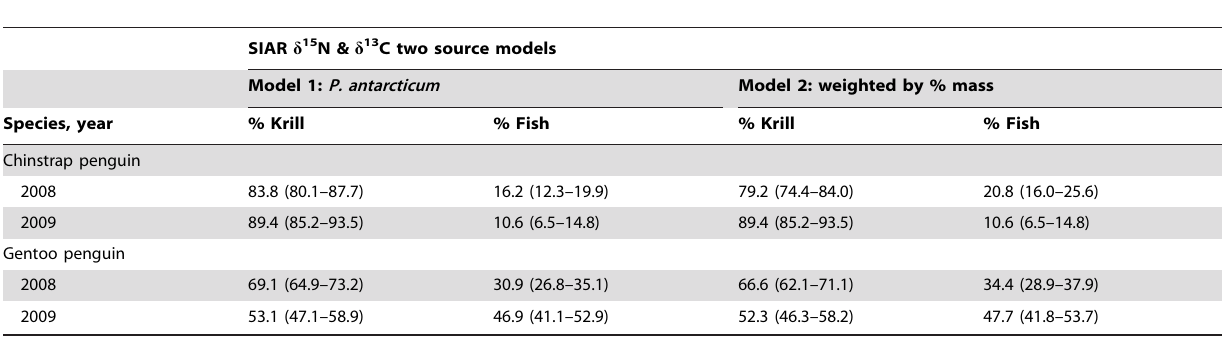
Table 3. Predicted diet composition of penguin chicks at Cape Shirreff, Livingston Island derived from stable isotope analysis using two variants of the SIAR two-source Bayesian mixing model.